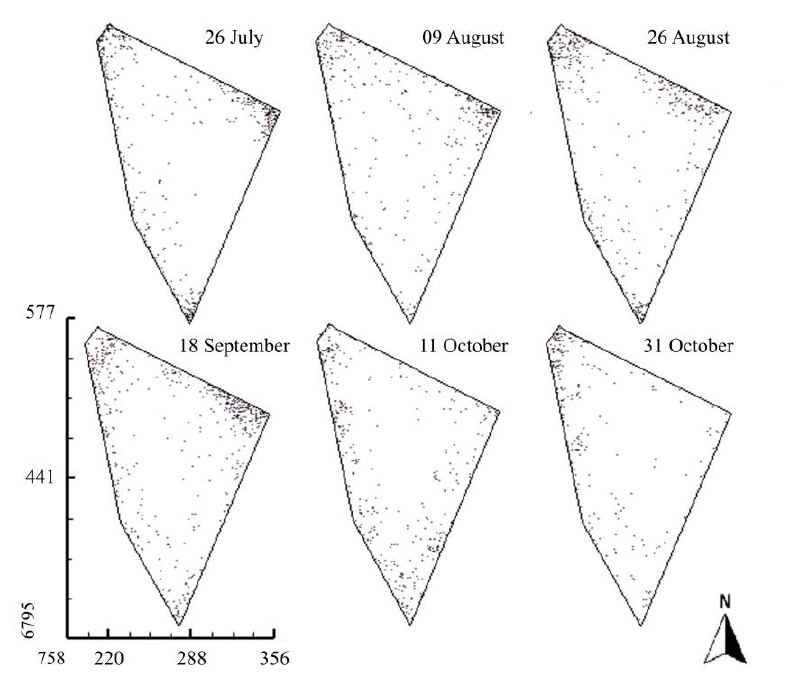
Figure 3. Spatiotemporal distribution of cattle dung patches in the paddock managed under light grazing intensity (sward height of 0.4 m) as a representation of dung distribution over di ff erent sampling dates in